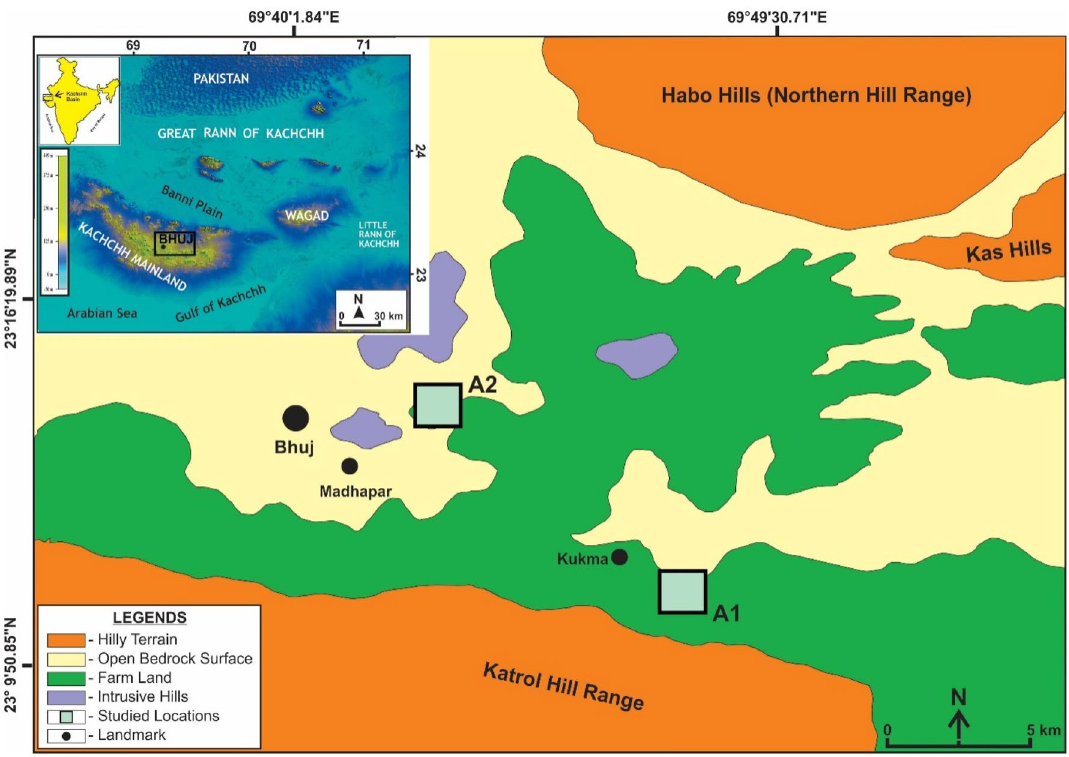
Figure 1. Study area location (generated using coreldraw version X7 and arcGIS version